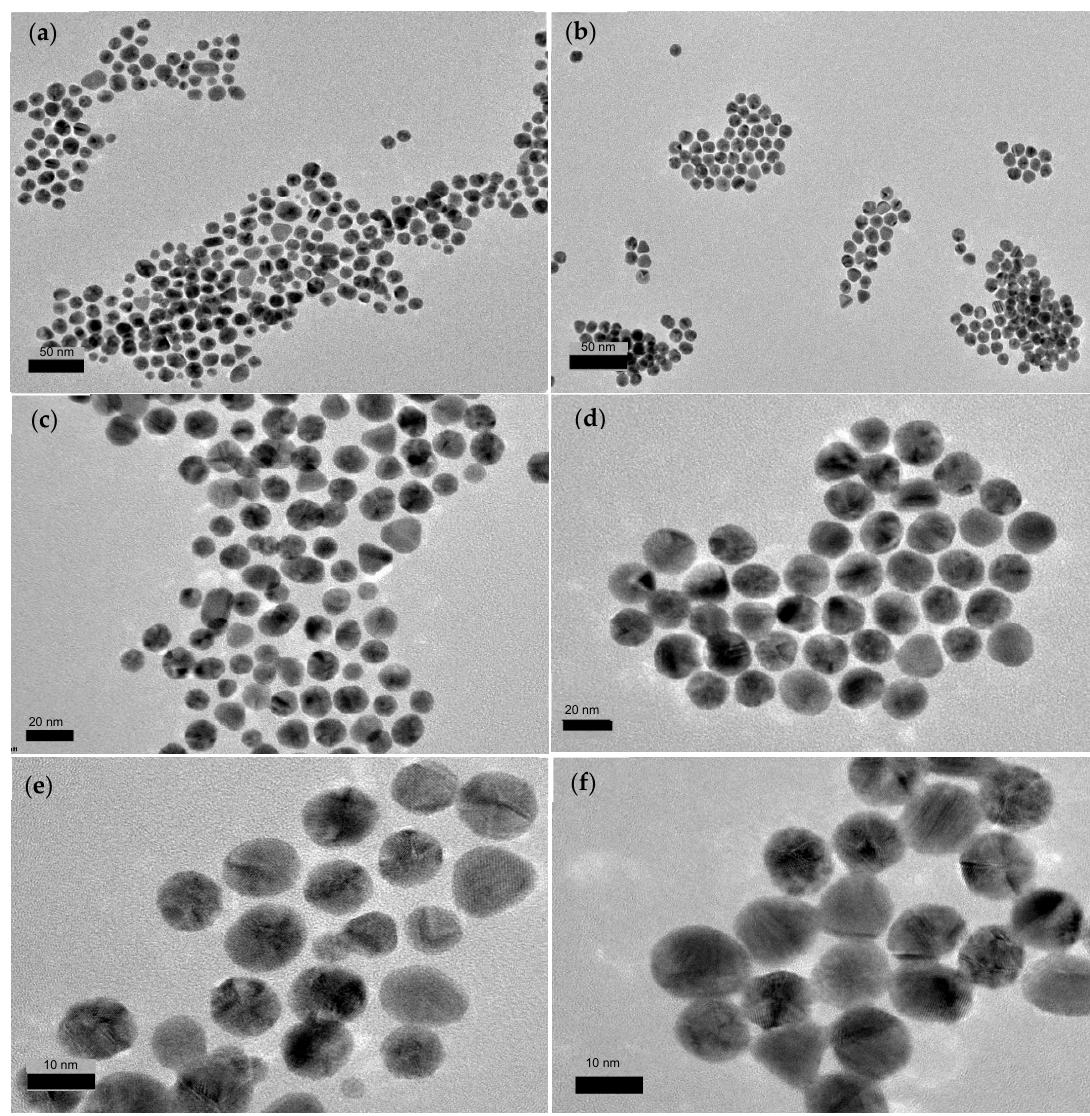
Figure 3. High-Resolution Transmission Electron Microscopy (HRTEM) images of the E. elatior-mediated AuNPs at ( a ) 50,000X magnification; ( c ) 100,000X magnification; ( e ) 250,000X magnification and in comparison, with AuNPs synthesised by sodium citrate at ( b ) 50,000X magnification; ( d ) 100,000X magnification; ( f ) 250,000X magnification.